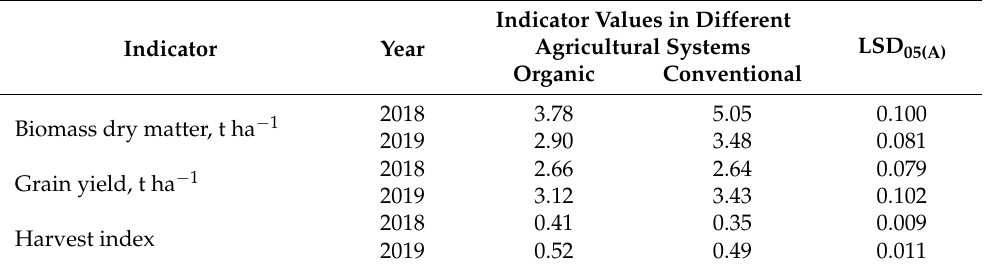
Table 1. Yields and harvest indexes of biomass and grain for organic and conventional farming systems. Indicator Values in Indicator Year